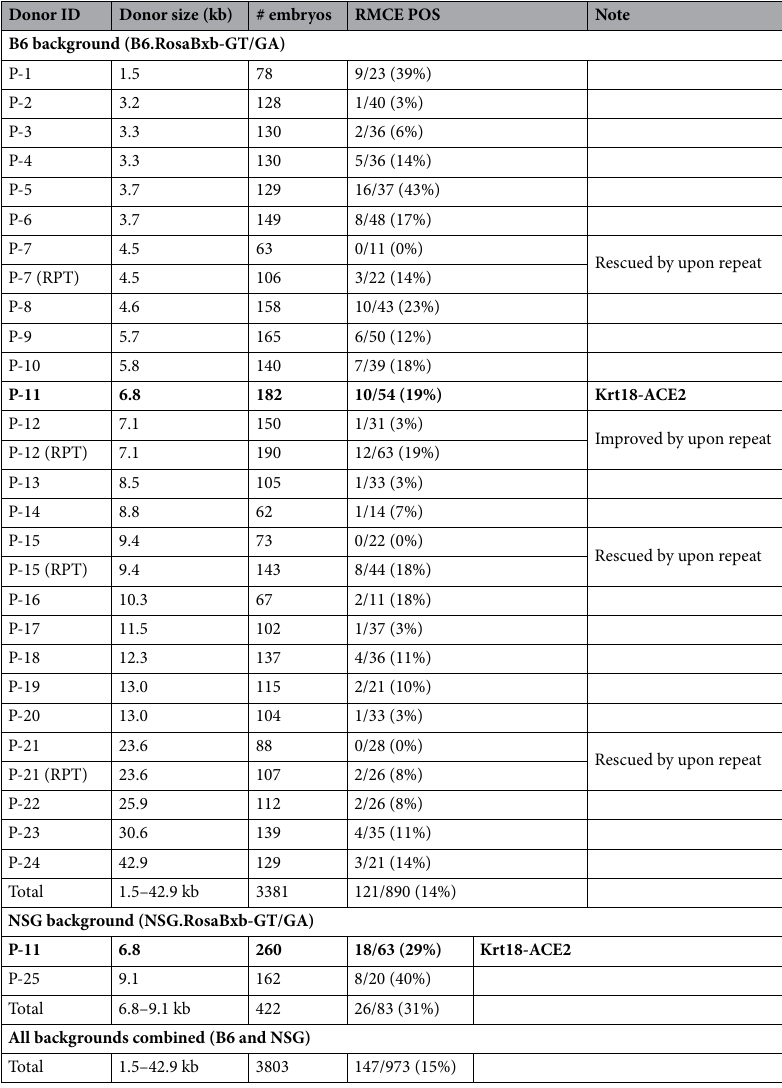
Table 3. Successful targeted transgenesis in dual site RosaBxb-GT/GA strains. Summary of 29 independent attempts to integrate 25 unique donor transgenes into the RosaBxb-GT/GA dual-site allele in B6 and/or NSG genetic backgrounds. Shown are DNA donor size, the number of microinjected embryos transferred, and the number of positive Founders animals which carry the transgene, expressed as a percentage of the number of animals screened. The Krt18-ACE2 construct (P-11) was delivered to both B6. RosaBxb-GT/GA and NSG. RosaBxb-GT/GA hosts, highlighted in bold. For a few constructs (P-7, P12, P-15, P-21), the microinjection was repeated following re-purification of the donor vector, which resulted in improved RMCE